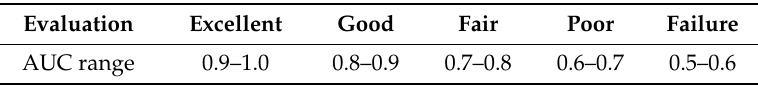
Table 3. Classification evaluation and corresponding AUC values.